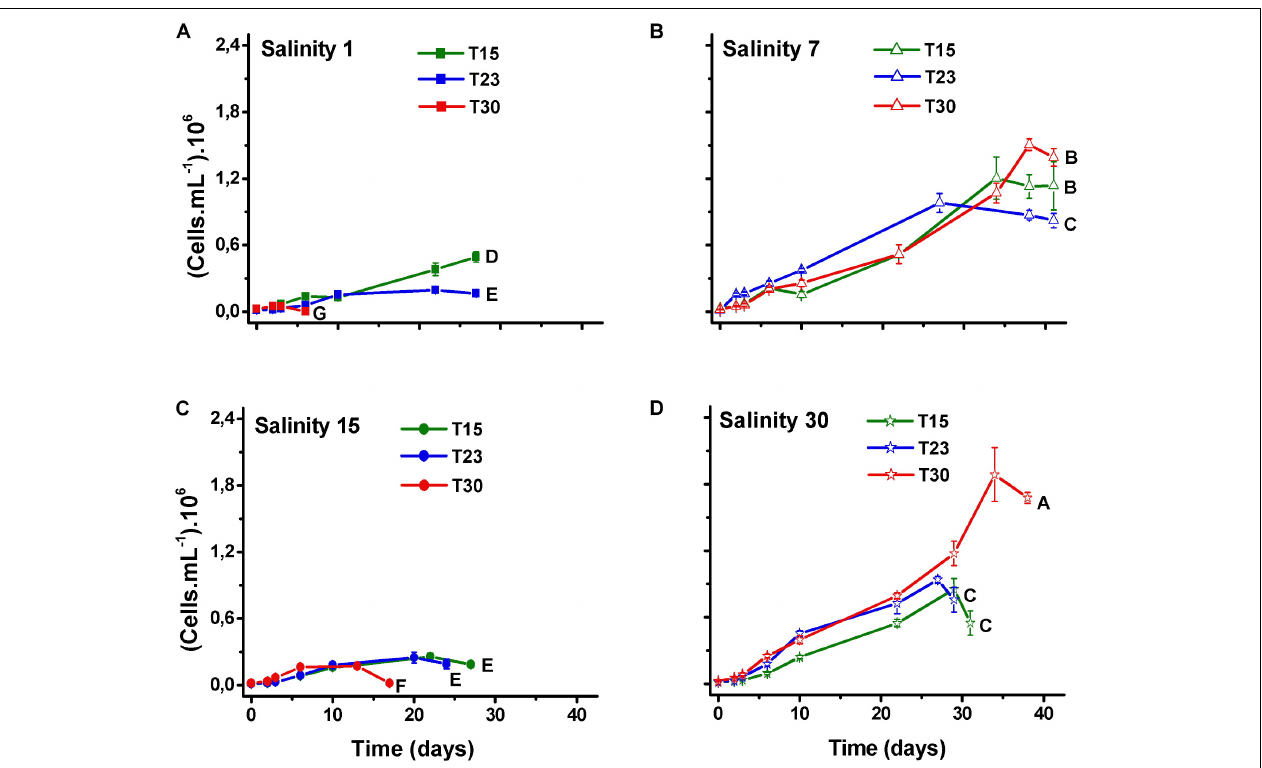
FIGURE 2 | Mean values of cell density ( ± SD; n = 3) of N. spumigena (NODSPU1) observed along the time in the factorial experiment, which analyzed the influence of temperature (T15, T23, T30 ◦ C) and salinity S1 (A) , S7 (B) , S15 (C) , and S30 (D) . Significant difference between treatments is indicated by letters (ANOVA, Tukey’s p <